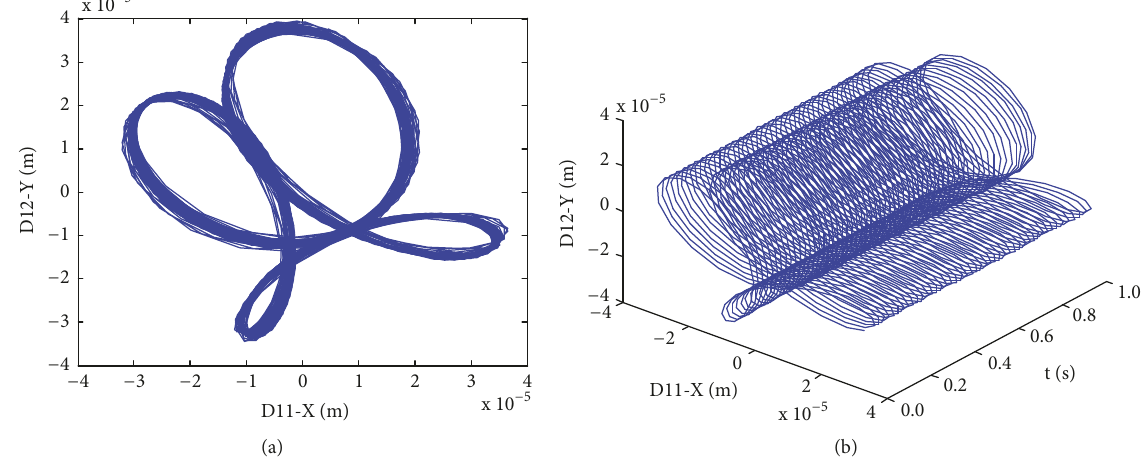
Figure 19: The synthesis of axis orbit is to extract the first three times fundamental frequencies of the D11 and D12 by the CFSM-PCA. (a) The axis orbit. (b) Relationship between axis orbit and